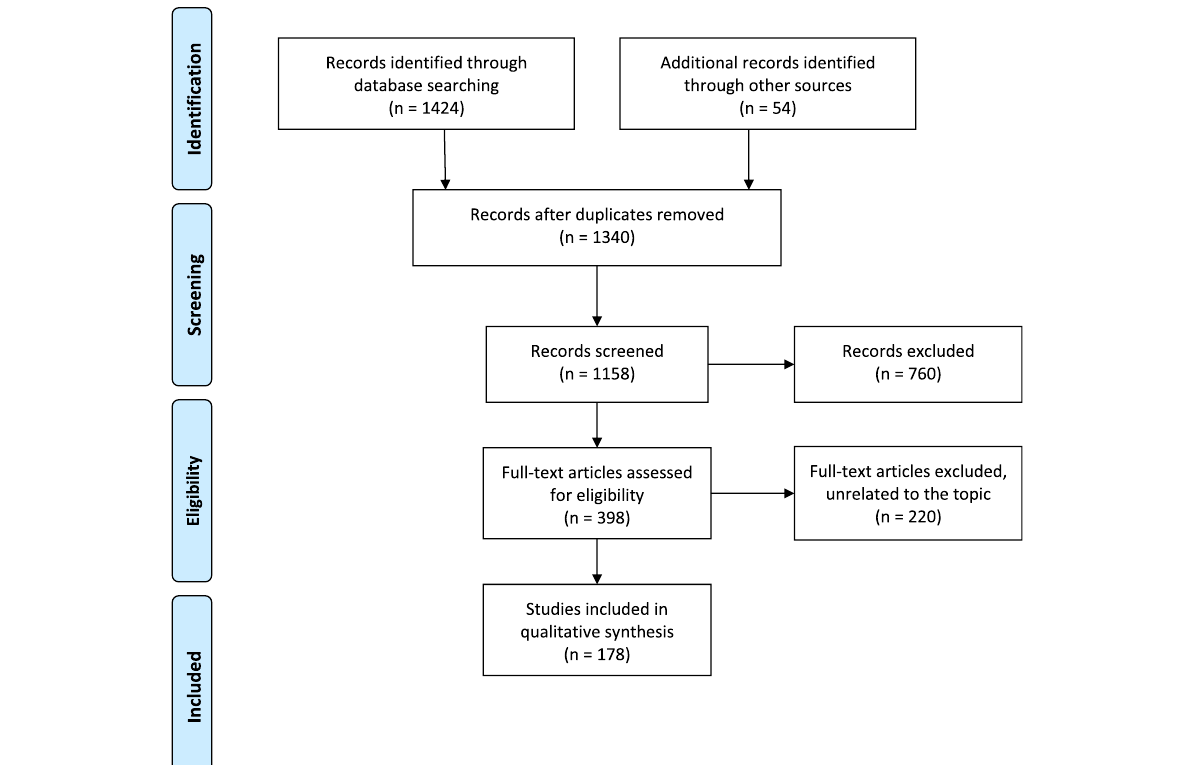
Fig. 1 Flowchart of study selection. Figure 1 includes all the relevant steps and main results of the literature search upon the main topic. The most relevant studies have been selected in accordance with the PRISMA guidelines. Specifically, observational studies, clinical trials, open label studies, systematic reviews, guidelines, commentaries, editorials, and letters to editors focusing on the review topic were